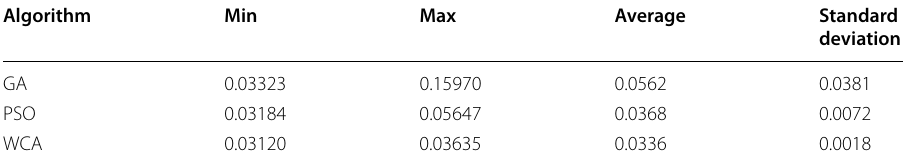
Table 3 Statistical analysis of objective functions